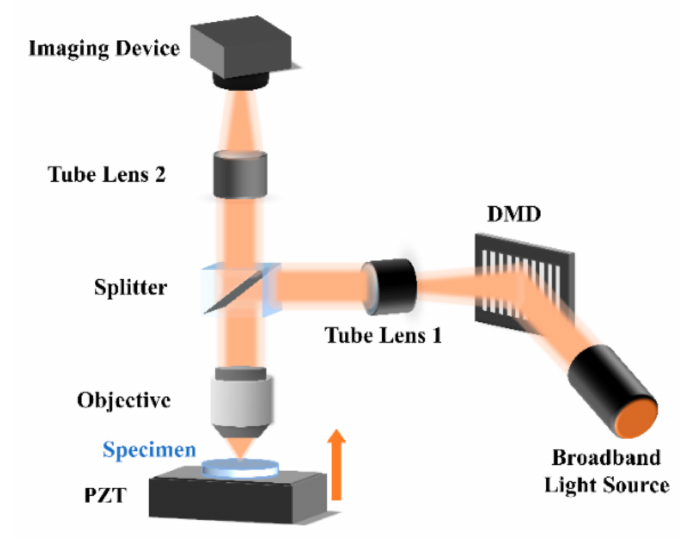
Figure 1. Schematic of the measurement system.